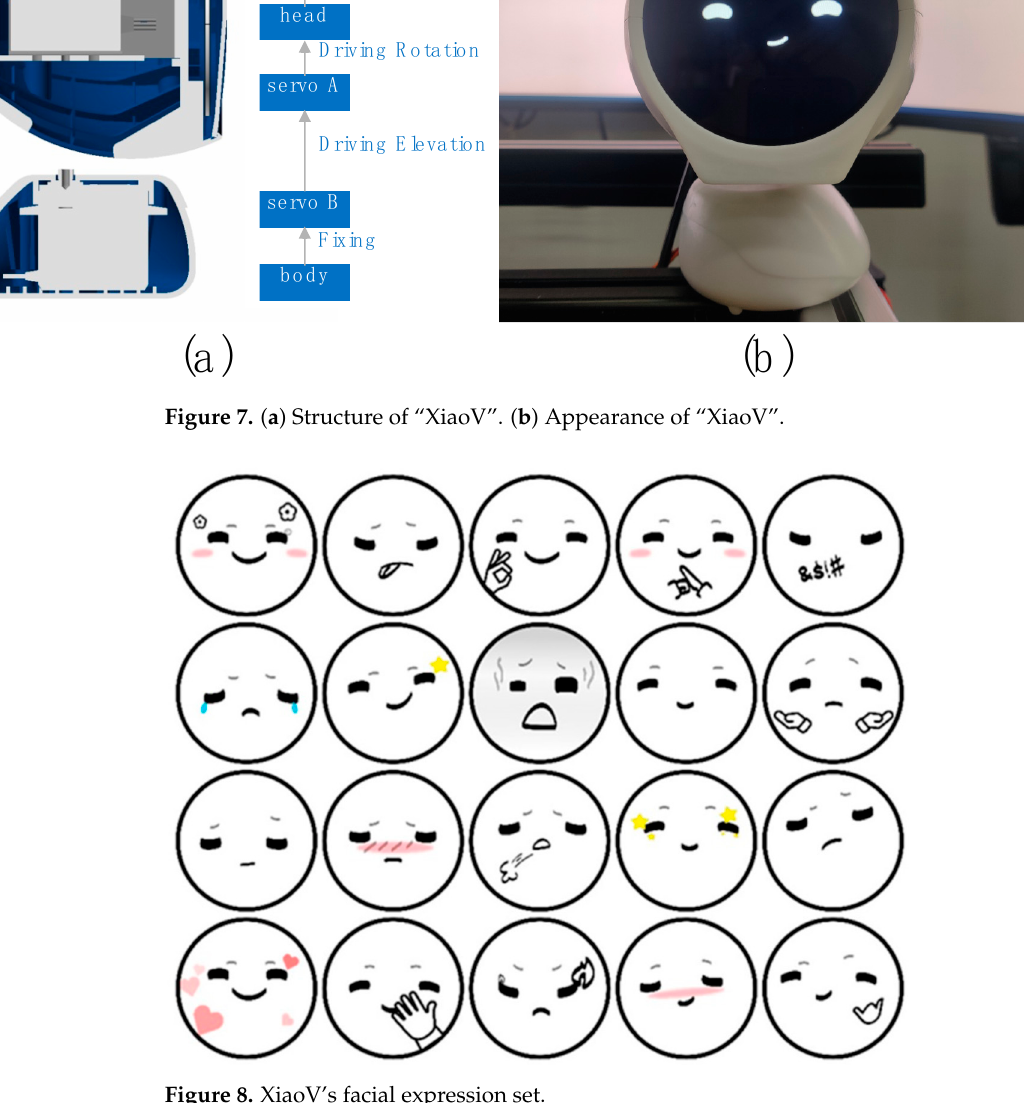
Figure 8. XiaoV’s facial expression set.